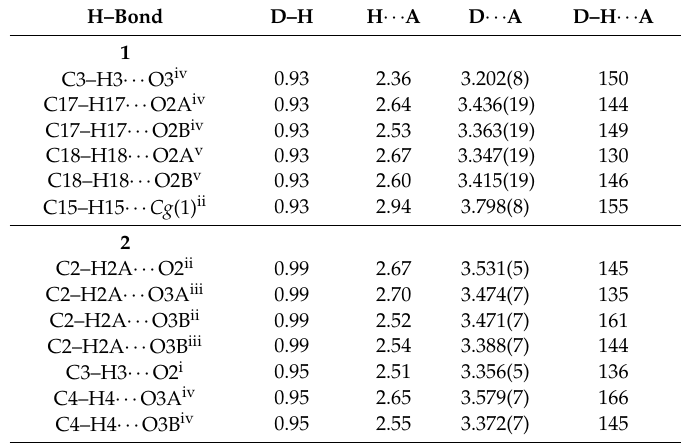
Table 4. Hydrogen bonding geometry (Å, °) for silver(I) complexes 1 and 2 .